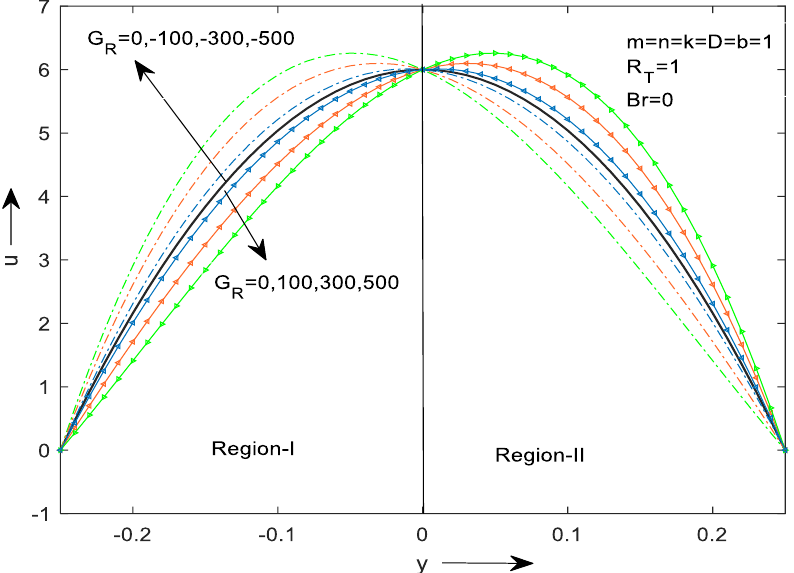
Fig. 2a. Velocity profiles for different values of G